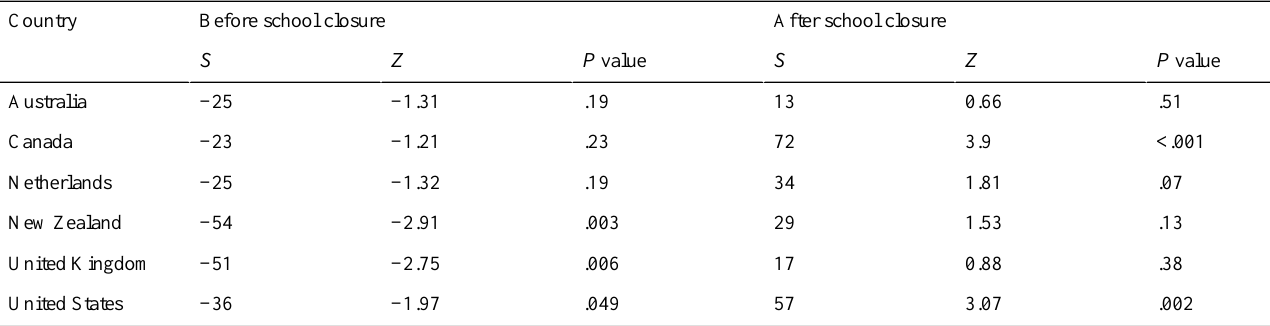
Table 2. Mann-Kendall test results for the comparison between suicide interest levels 2 weeks before school closure and 2 weeks after school closure for selected